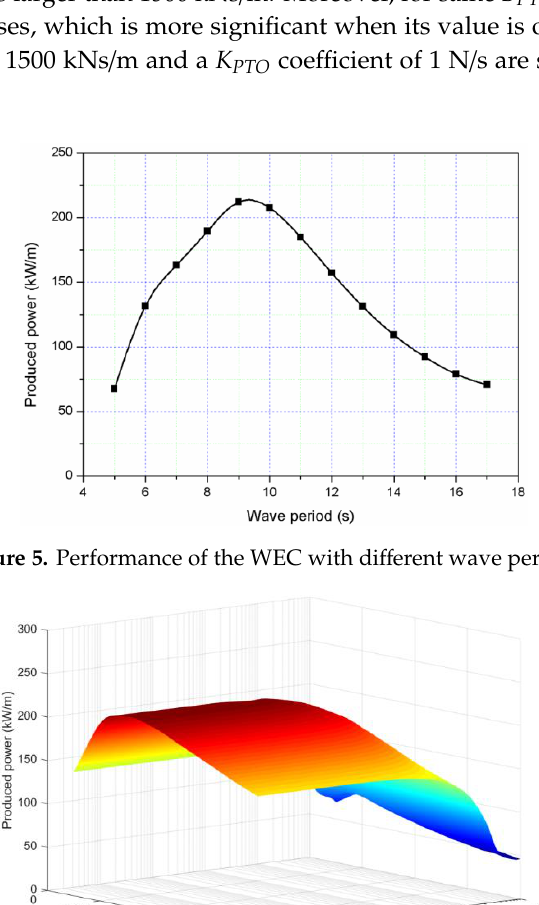
Figure 4. Effects of the daft on the WEC: ( a ) semisubmersible surge; ( b ) semisubmersible pitch.